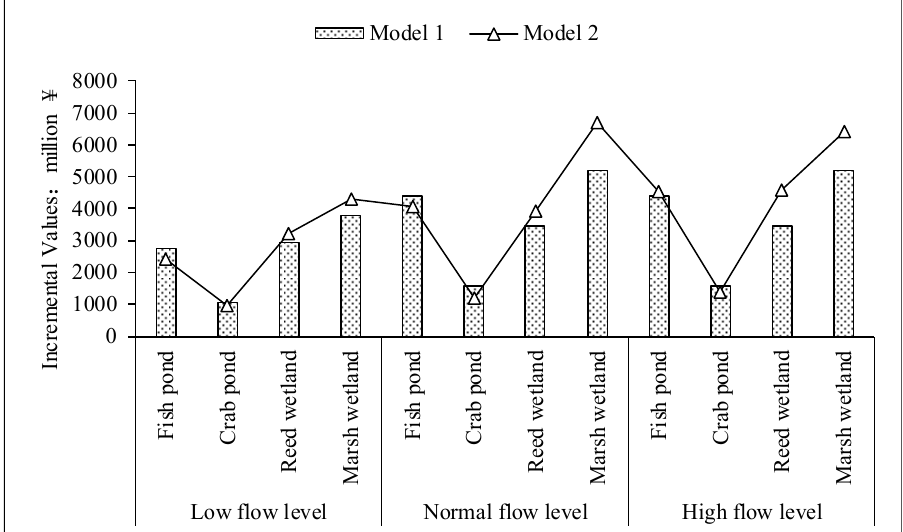
Figure 11. Comparison of incremental ecological service value obtained by the two models under different scenarios.